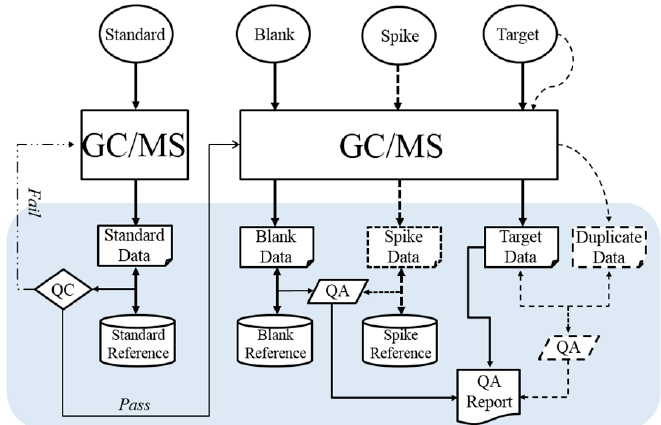
Figure 1. The process of experimentally generating data and assessing quality and usability of data. Dashed lines indicate optional procedures. Samples include both QC (Quality Control) samples (Standard, Blank, Spike, and Duplicate) and Target samples. Samples are injected into GC–MS (Gas Chromatography–Mass Spectrometry) to generate the corresponding data. The overall workflow of QUICK (Quality and Usability Investigation and Control Kit) is illustrated in the grey box. Standard Data are compared with Standard Reference to generate QC report. Blank, Spike, Duplicate, and Target data are used to report QA (Quality Assessment) results.